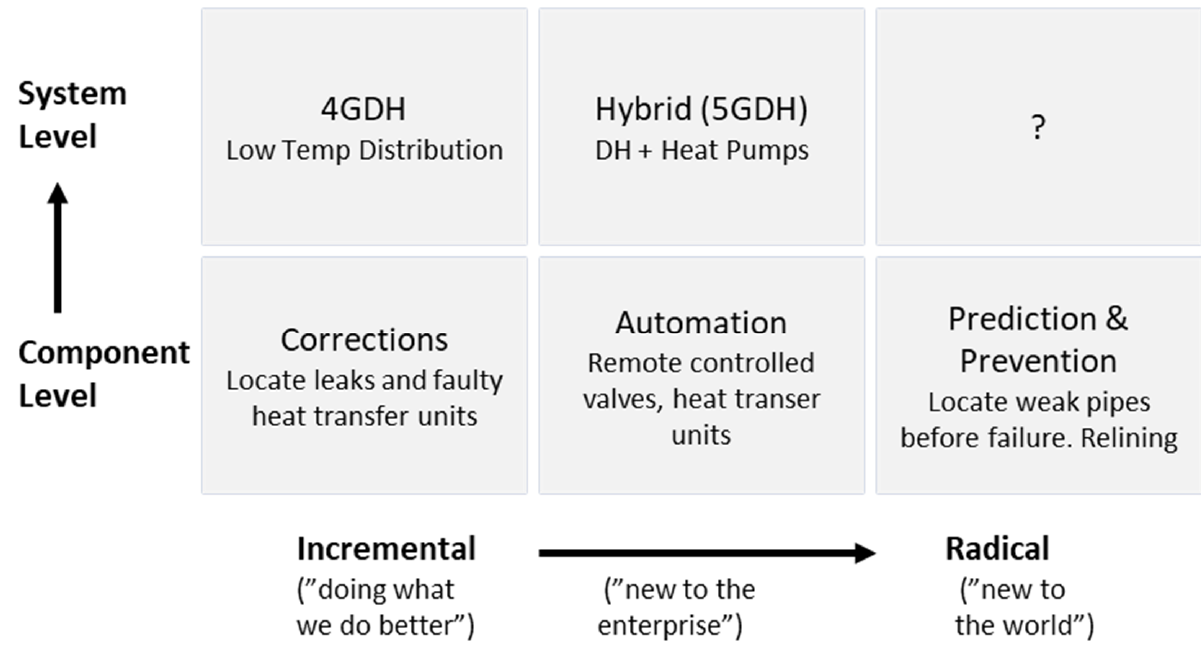
Figure 1. The different dimensions of innovation that are applied to the distribution of district heating (DH), based on [14]. Examples of innovation in the DH sector. On the lower level is the component type of innovation, from left incremental innovation to radical innovations. On the upper level is the system type of innovation. In the upper right corner is a question mark. It can be disputed what is radical innovation at the system level.